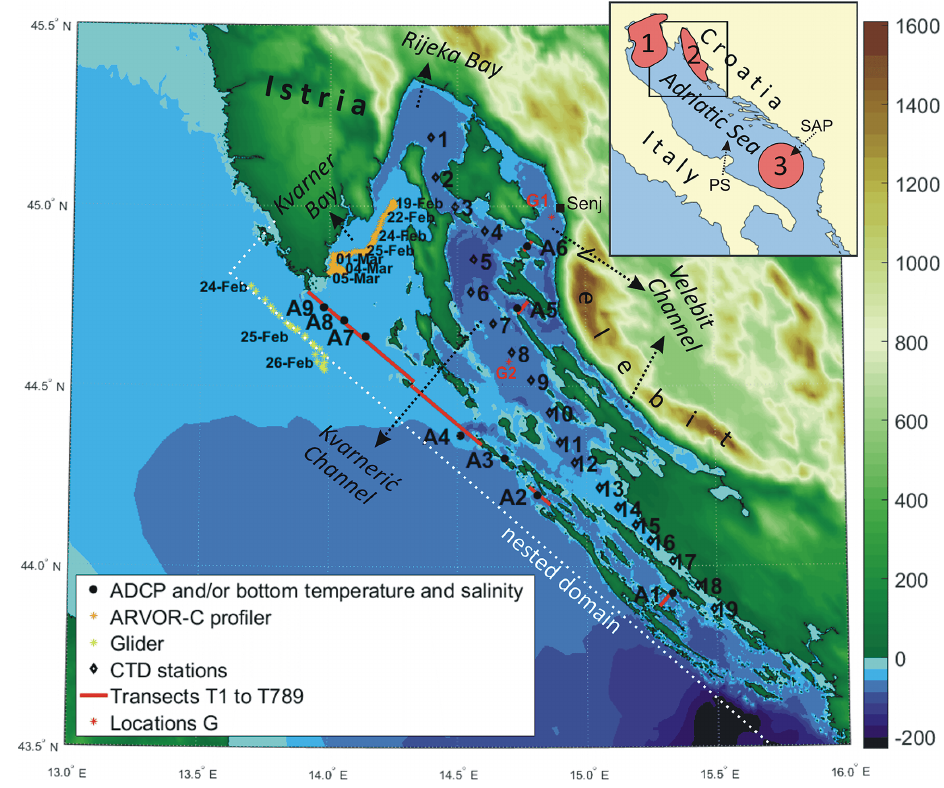
Figure 1. Geographical position and bathymetry of the coastal northeastern Adriatic, with indicated measurements conducted through the NAdEx 2015 experiment: stations A1 to A9 (black circles) where ADCP/SBE911 were moored at the bottom, stations 1 to 19 (black diamonds) where CTD probe profiling, ARVOR-C profiling (orange stars), and glider profiling have been executed (yellow stars). Locations G1 and G2 (red stars) have been used for computation of temporal changes in heat losses, buoyancy changes and thermohaline properties from the modelling system, while the definition of the bora episode has been based on ALADIN/HR wind modelled at the G1 location. Transects T1 to T6 and T789 are marked by red lines on which the fluxes and transports have been estimated; the transect labels are associated with the equivalent A station labels. Nested ROMS domain boundary is indicated by the dashed white line. Inset numbers 1, 2 and 3 denote the areas where dense-water formation is documented in the Adriatic Sea, while PS and SAP stand for Palagruža Sill and South Adriatic Pit,